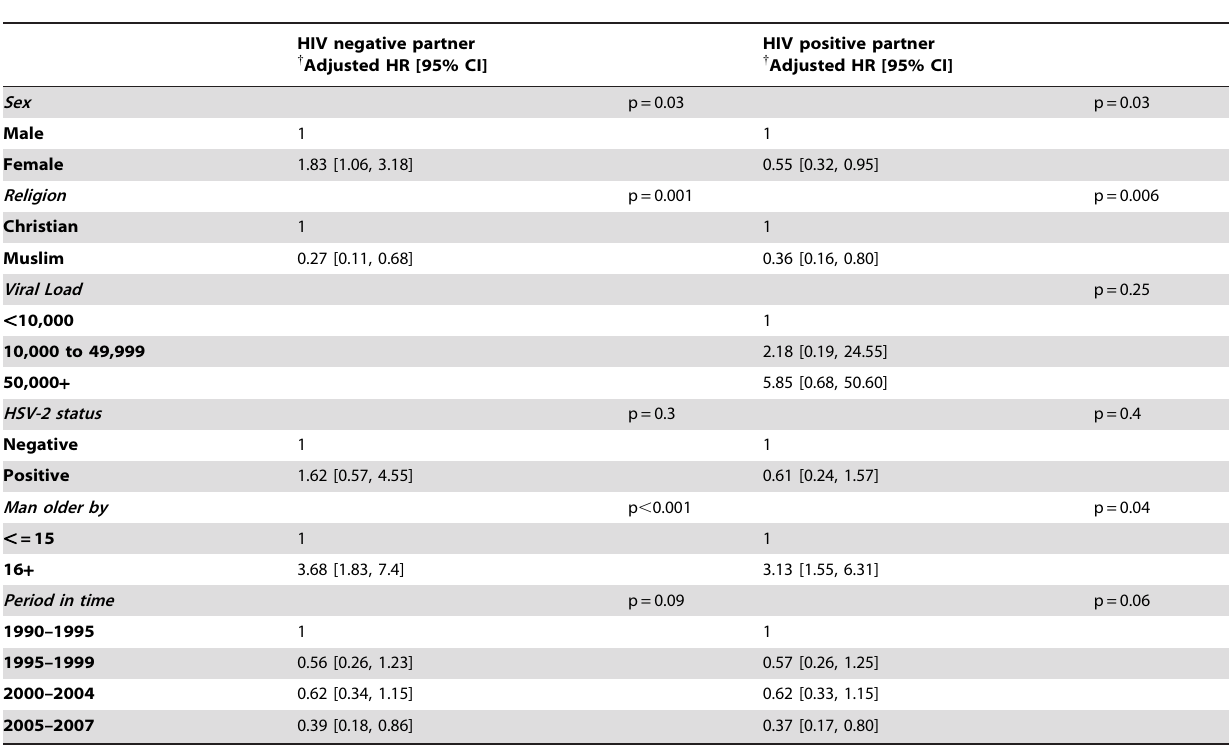
Table 2. Factors associated with HIV seroconversion and transmission in serodiscordant couples: multivariable analyses.